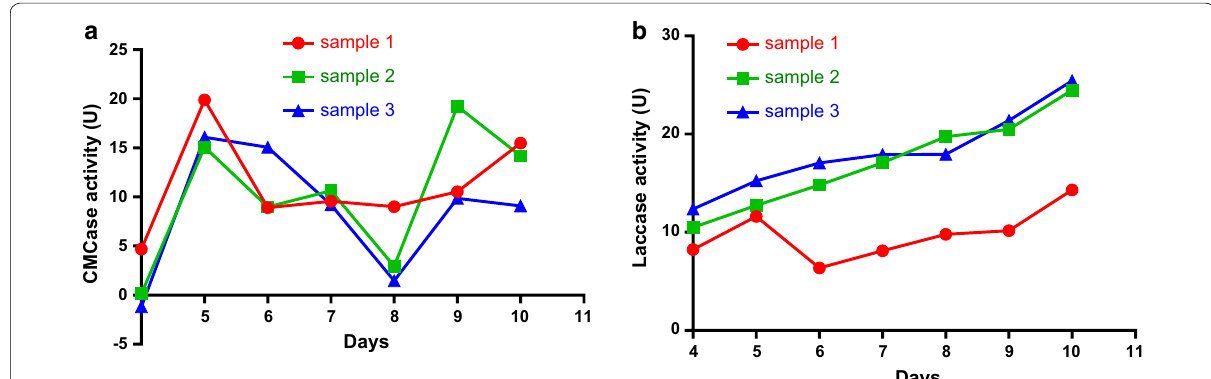
Fig. 3 a CMCase activity of A. brunnescens during liquid-state fermentation. b Laccase activity of A. brunnescens during liquid-state fermentation